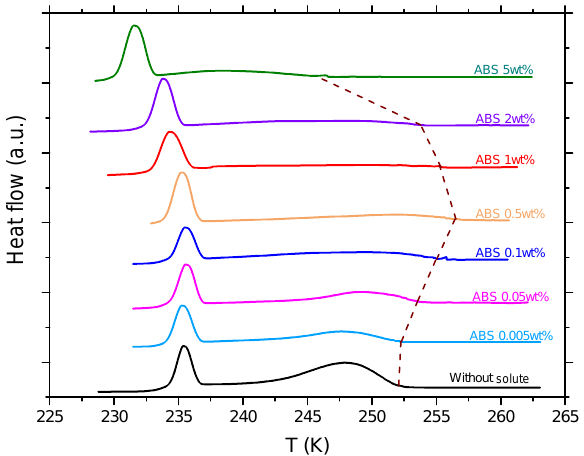
Figure 3. Compiled results of the freezing experiments with mi- crocline. Heterogeneous freezing onset temperatures, T het (filled solid symbols connected via thin lines); homogeneous freezing on- set temperatures, T hom (open symbols at T = 225–237K) and ice melting temperatures, T melt (open symbols at T = 267–273K) as functions of the solution water activity, a w , for various solutes (for symbols and colors see insert). All suspensions contain 2wt% mi- crocline. Dash-dotted black line: ice melting point curve. Dotted black line: homogeneous ice freezing curve for supercooled aque- ous solutions obtained by horizontally shifting the ice melting curve by a constant offset (cid:49)a hom w (T ) = 0.296. Solid black line: horizon- tally shifted from the ice melting curve by (cid:49)a het w (T ) = 0.187 de- rived from the heterogeneous freezing temperature of the suspen- sion of microcline in pure water (filled black square at a w = 1). Symbols are the mean of at least two separate emulsion freezing experiments. Three symbols carry error bars to show representative experimental variations (min to max) in T het and a w .